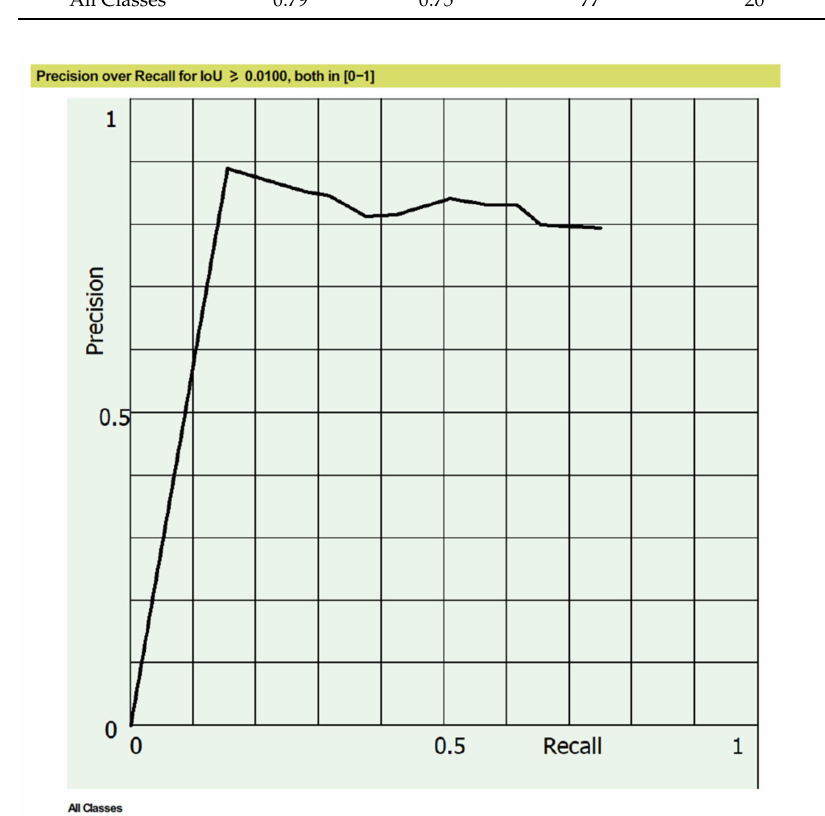
Figure 4. Precision over recall for IoU